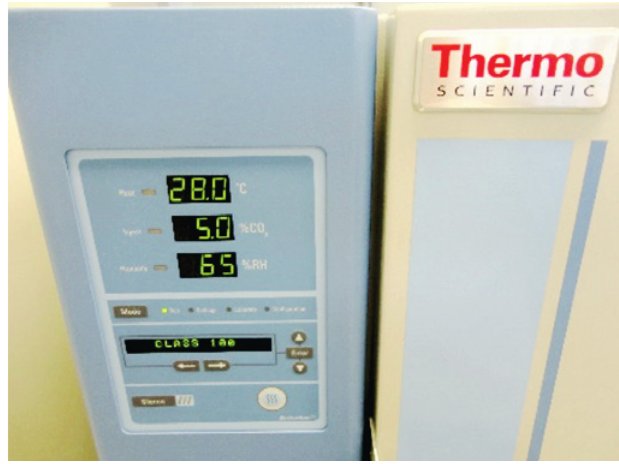
Figure 2 Carbonation chamber – exposure conditions of the specimens